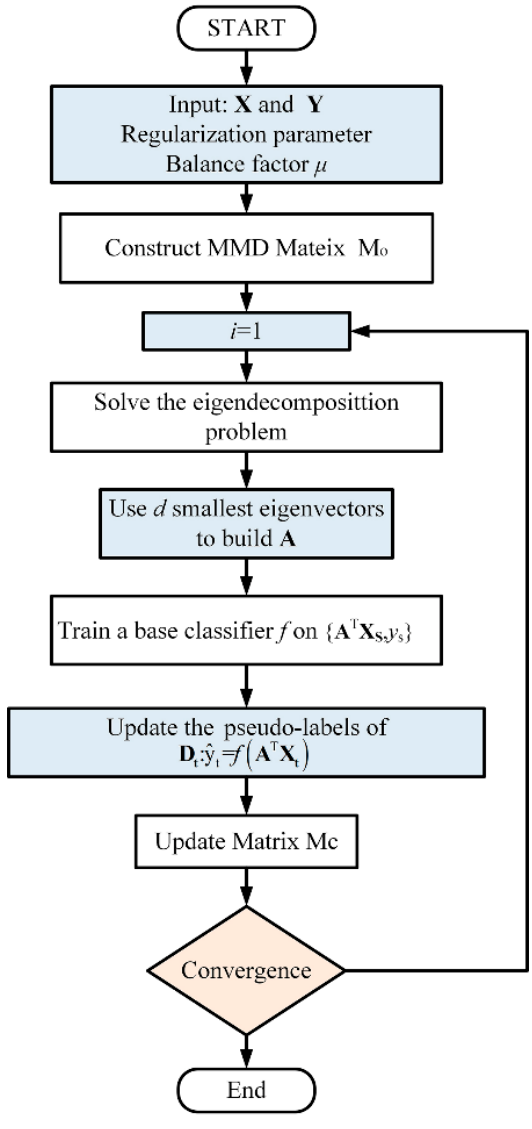
Figure 3. Flowchart of BDA algorithm.